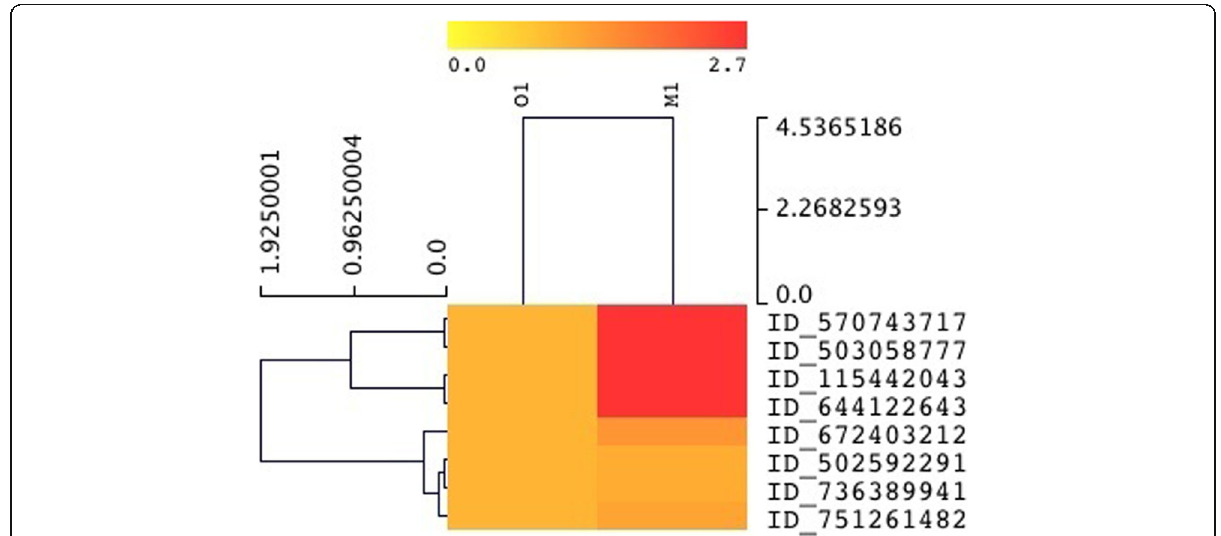
Fig. 4 Heat map showing high expression of heat shock proteins in the M1 soil, refer to Additional file 4: Table S2 for